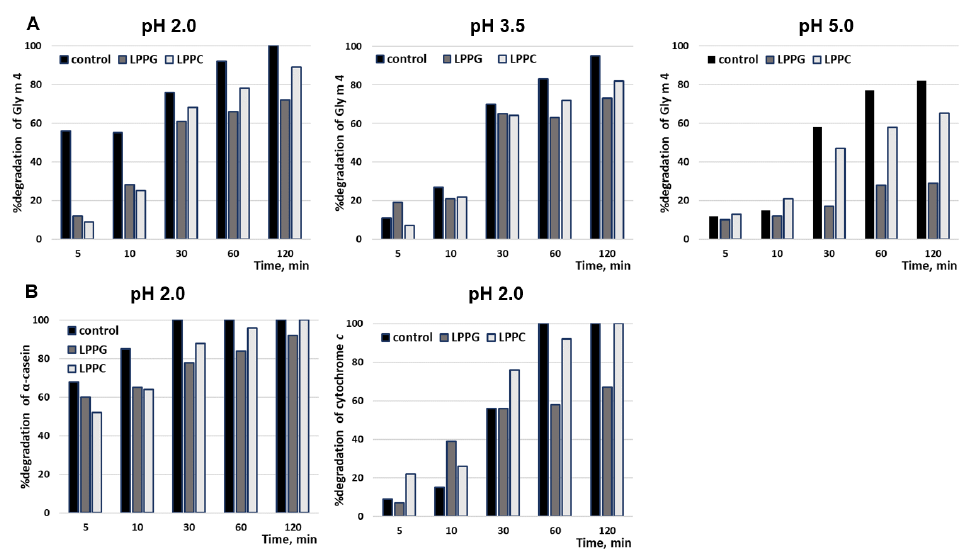
Figure 4. Analysis of pepsin digestion of Gly m 4 and model proteins: ( A ) Gly m 4 at different pH values (enzyme-to-substrate mass ratio of 1:2000 or 1:200 at pH 2.0 or pH 3.5 and pH 5.0, respectively); ( B ) α -casein and cytochrome c cleaved at pH 2.0 (enzyme-to-substrate mass ratio of 1:2000 and 1:10,000, respectively). The bands corresponding to intact proteins were registered using Gel Doc XR+ imaging system (Bio-Rad) and Image Lab Software. The percentage of the digested proteins was calculated by formula (So − Sa)/So × 100%, where So is an area of the protein band in a sample without pepsin, and Sa is an area of the protein band at a specified time. Controls—proteins cleaved in the absence of